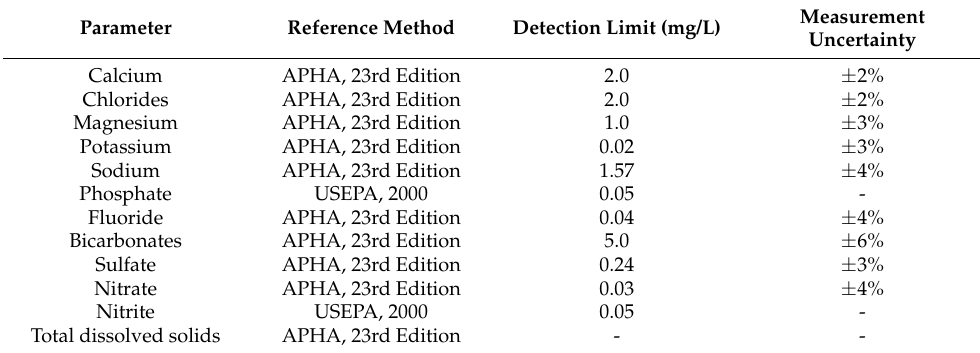
Table 1. Laboratory detection limits and relevant details for selected constituents. Parameter Reference